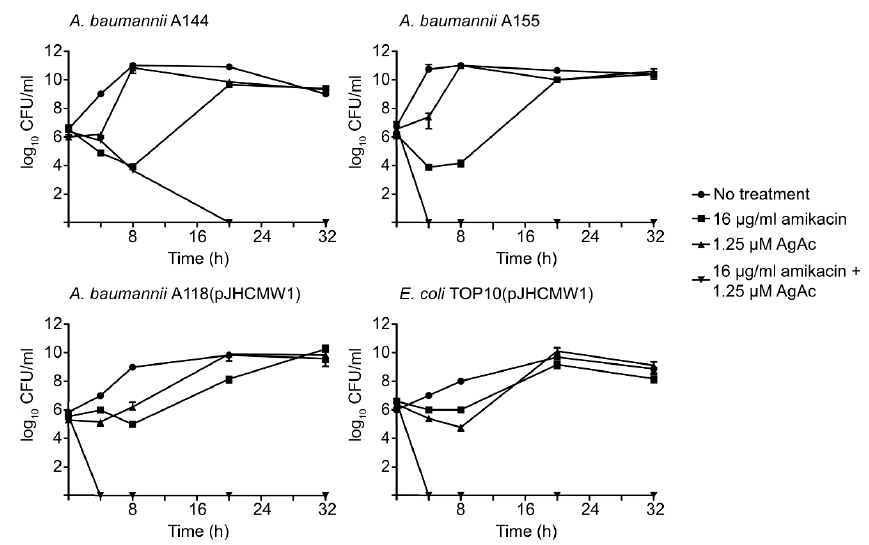
Figure 3. Time-kill assay curves for amikacin in the presence of silver acetate. A . baumannii A155, A144, and A118(pJHCMW1), and E. coli TOP10(pJHCMW1) cultures in Mueller - Hinton broth were incubated until they contained the indicated CFU/mL. Then, the different compounds were added, and the cultures were incubated at 37 °C. The CFU/mL values were measured at different intervals. AgAc, silver acetate.